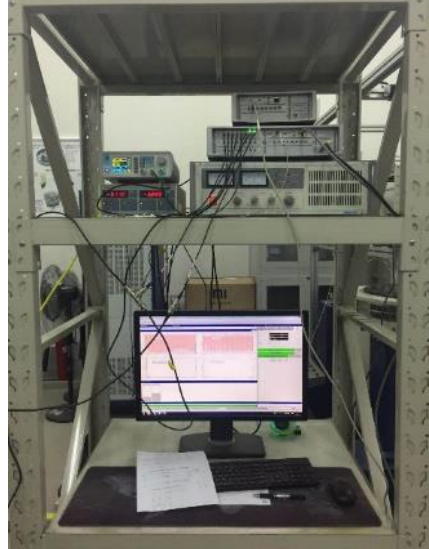
Figure 18. Experimental setup.